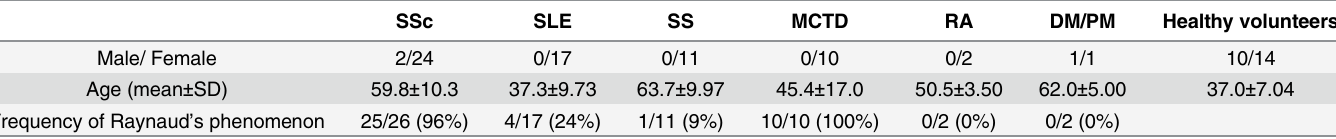
Table 1. Characteristics of patients and controls.